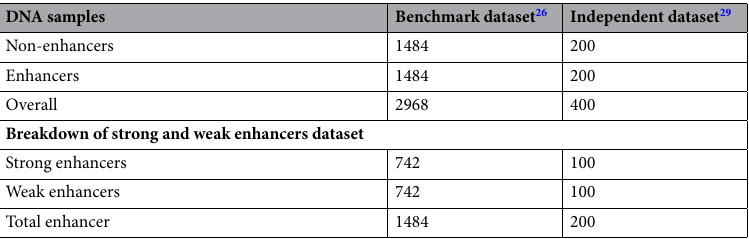
Table 1. Breakdown of the benchmark datasets of DNA enhancers and